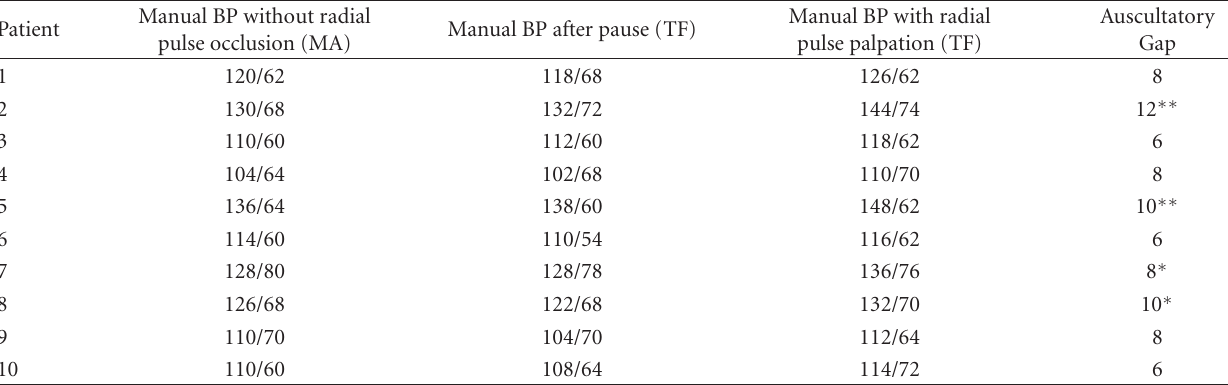
Table 2: Manual blood pressure in SSc patients with auscultatory